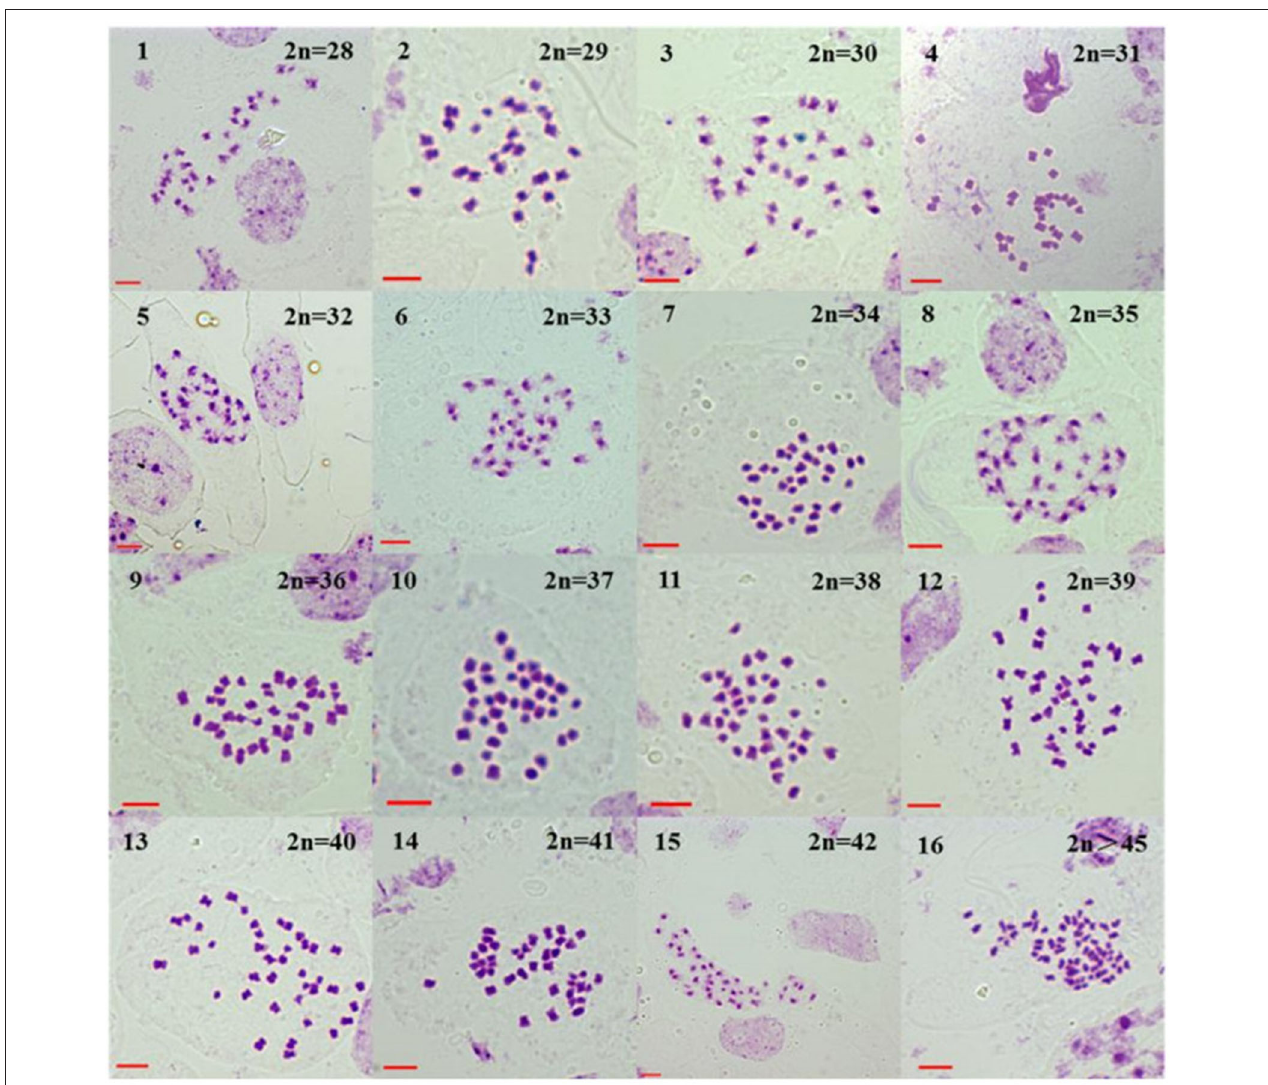
FIGURE 5 | Somatic chromosome numbers of the glyphosate-tolerant first-generation progeny of BC1 (BC1mF1R). BC1mF1R indicates the glyphosate-tolerant first-generation progenies of the first backcross generation (BC1) obtained from wild Brassica juncea × F1R. F1R indicates glyphosate-tolerant F1 hybrids obtained from wild B. juncea × glyphosate-tolerant transgenic oilseed rape. Progenitors in front of the × are always the maternal plants, and the progenitors after the × are always the paternal plants. All bars: 5 µ